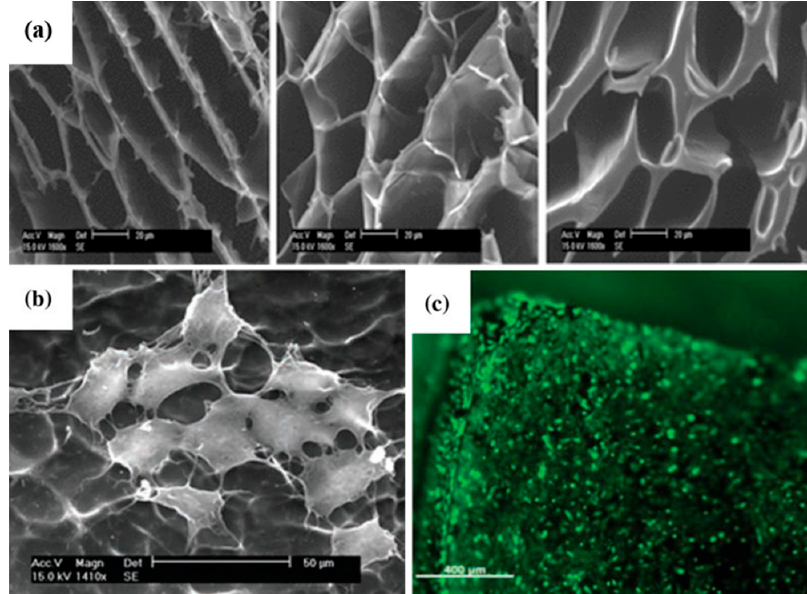
Figure 5. Scanning electron micrographs of the poly (3-thiophene acetic acid) (PTAA) hydrogels with different crosslinking densities: low (left), middle (middle), and high (right) ( a ). Morphology of C2C12 myoblast cells at 72 h of post-seeding observed by SEM ( b ) and by a fluorescence assay ( c ). Adapted with permission from [125]. Copyright 2012 John Wiley and Sons.